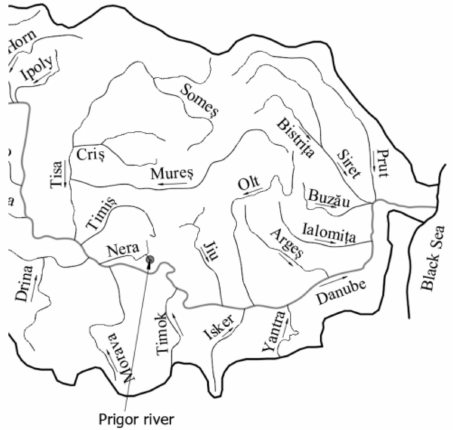
Figure 3. The location of Prigor River and Prigor hydrometric station.